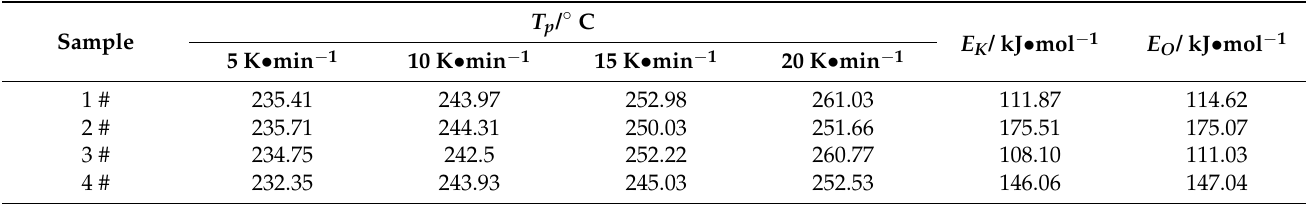
Table 3. T p of samples at different heating rates and calculated value of E a .